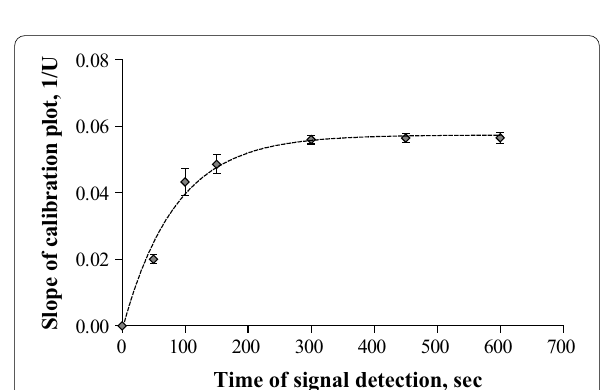
Fig. 4 The dependence of the slope of calibration plots on time of signal detection. The cellulose samples were incubated in air-saturated 1% CMC solution in 0.1 M acetate buffer (pH 5.0) at 25 °C; the final concentration of glucose oxidase added was 12 U/ml